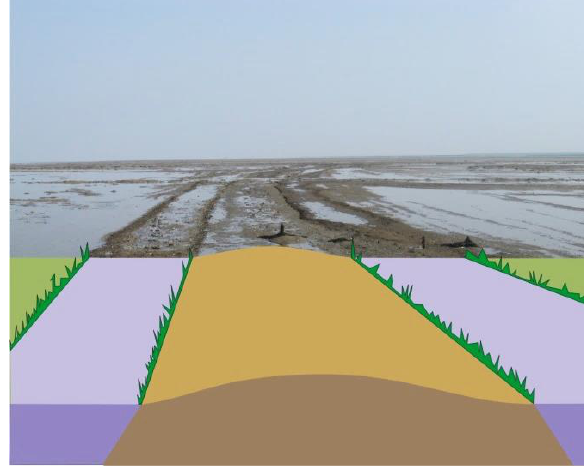
Figure 10. Reconstruction of a historical lane with ditches on either side. Photograph and sketch: J.